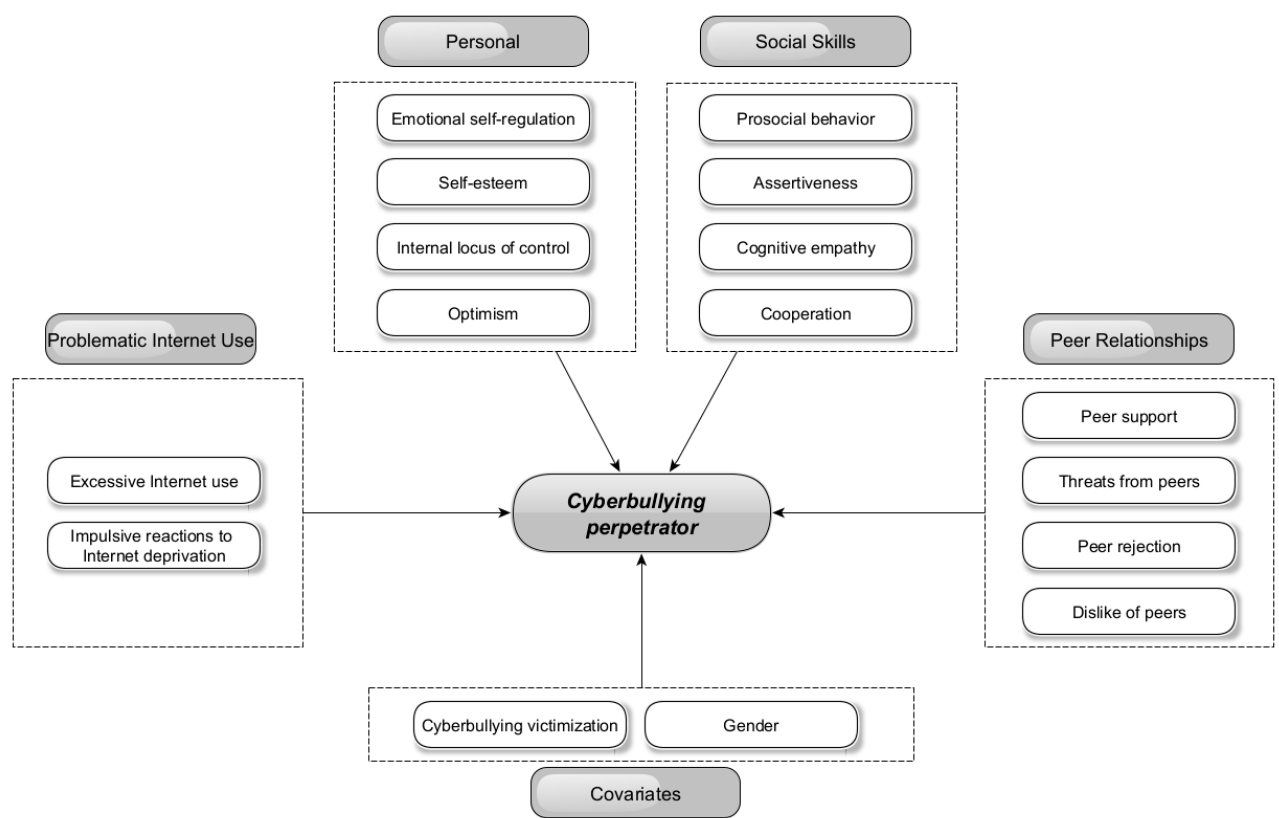
Figure 1. The grid of explanatory and control variables used in the cyberbullying analyses.